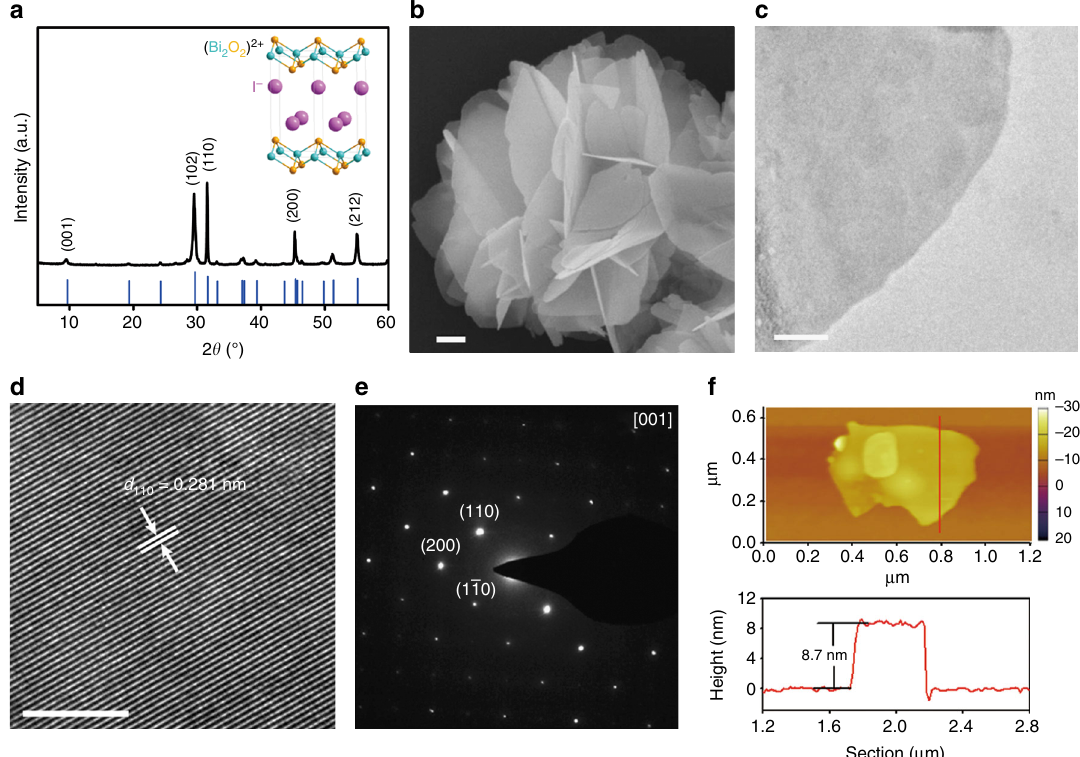
Fig. 1 Structural characterizations of BiOI nanosheets. a XRD pattern and (inserted) schematic crystal structure; b SEM image; c , d TEM images at different magni fi cations; e SAED pattern; f AFM image and corresponding height pro fi le. Scale bar, 200 nm ( b ); 50 nm ( c ); 5 nm ( d